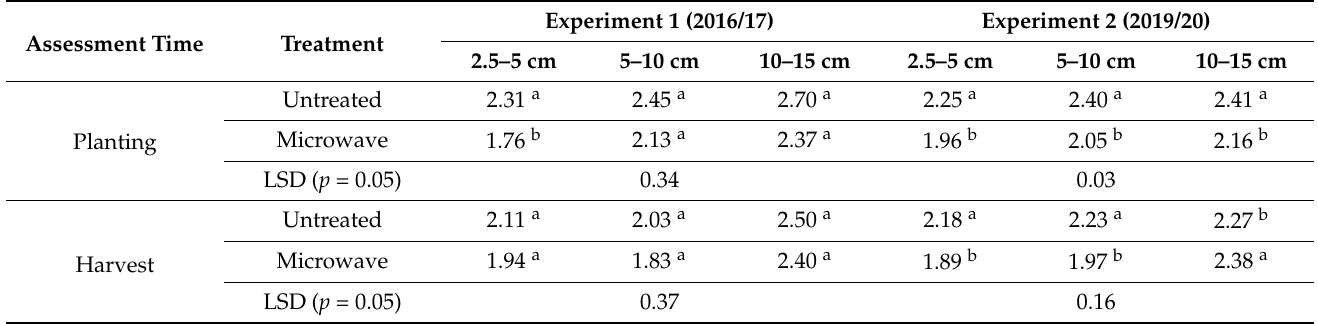
Table 3. Concentrations of DNA of Pythium spp. (clades I and F) in soil (Log 10 pg DNA g − 1 soil) at different depths following treatment with microwave in two field